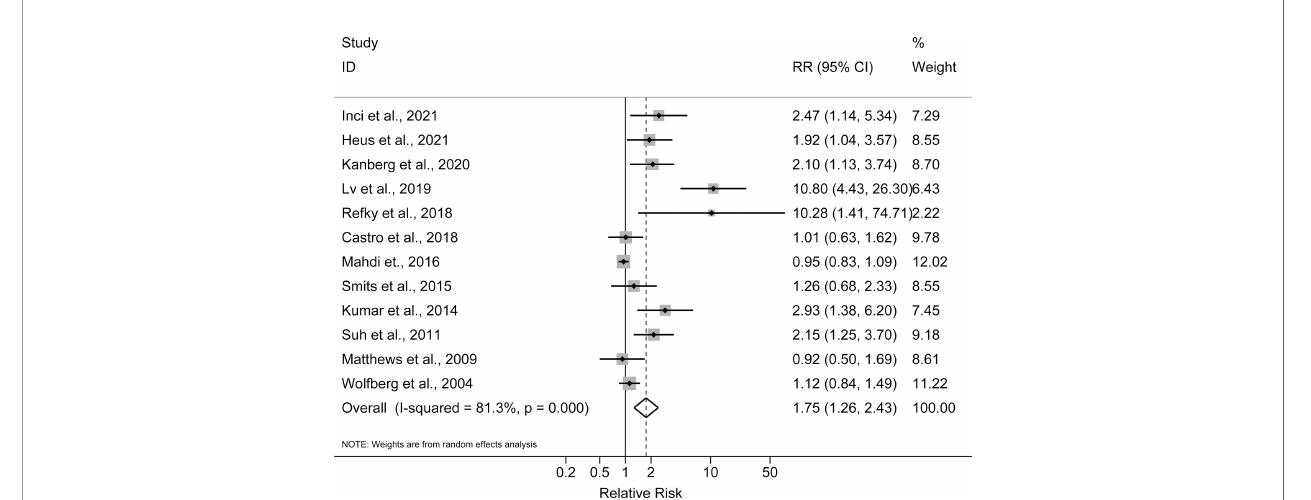
FIGURE 2 | Forest plot of the association between obesity and postoperative complications in ovarian cancer patients.